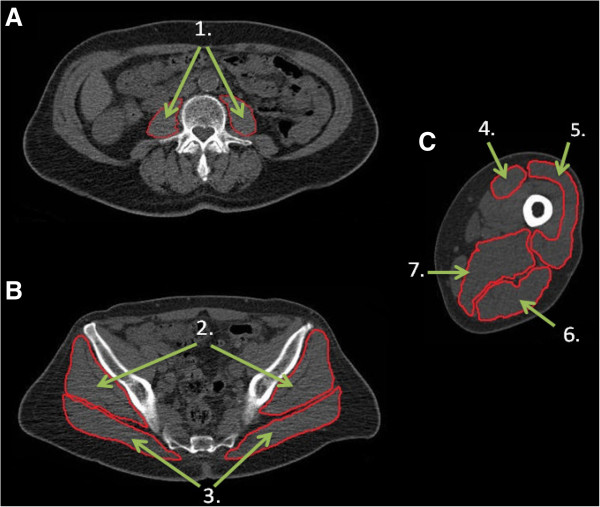
Representative example of computed tomography (CT) scans from an older adult showing A) abdominal scan; B) hip scan; C) thigh scan. 1. Psoas; 2. Gluteus Medius and Minimus; 3. Gluteus Maximus; 4. Rectus Femoris; 5. Vastus Lateralis; 6. Hamstrings compartment; 7. Adductor Magnus and Longus.